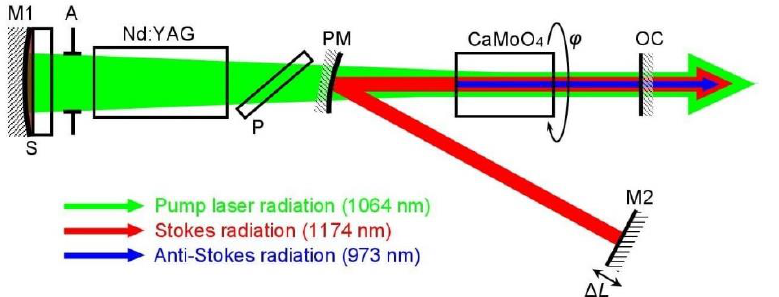
Figure 3. Optical scheme of the laser system: Nd:YAG and CaMoO 4 are the active elements of the pump laser and the parametric Raman laser, respectively; M1 and M2 are the end mirrors of the pump laser and the parametric Raman laser, respectively; S is the passive laser shutter (dye) at the M1 mirror; PM is the pumping mirror of the parametric Raman laser; OC is the output coupler of the laser system; A is the aperture; and P is the thin-film polarizer.